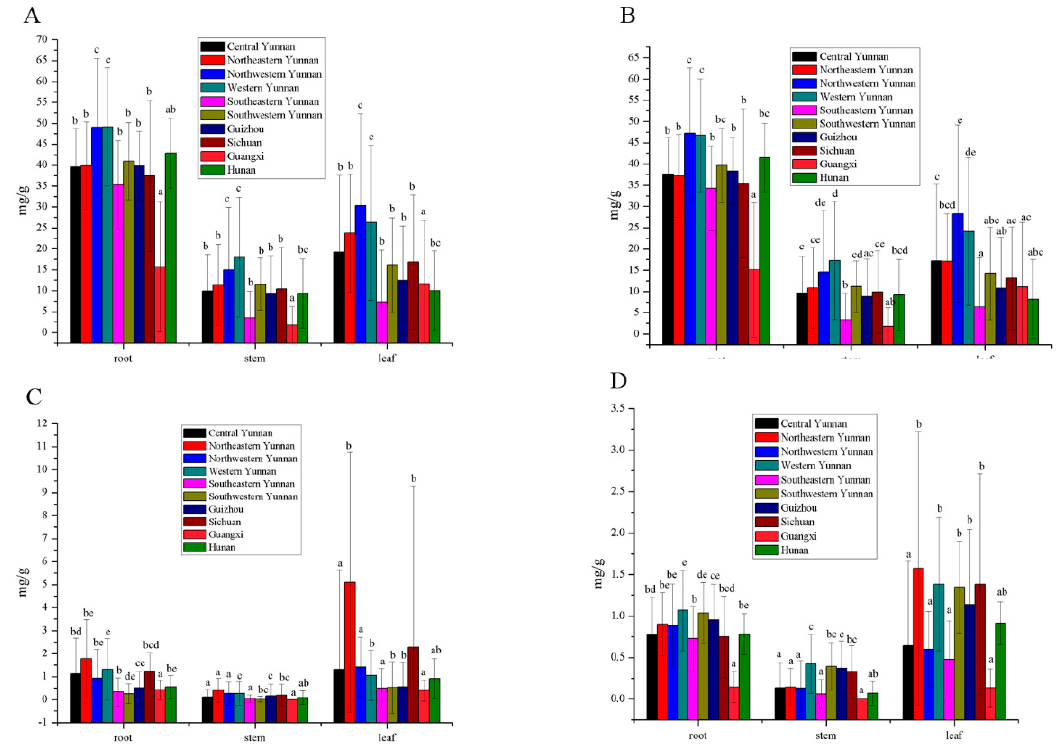
Figure 5. Different parts (root, stem, and leaf) in the content of total secoiridoids ( A ), gentiopicroside ( B ), sweroside ( C ), and swertiamarin ( D ) of G. rigescens in southwestern China ( P < 0.05).